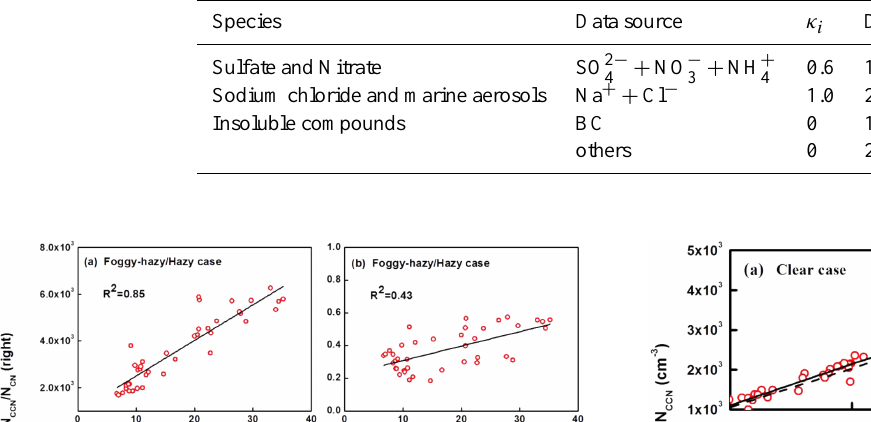
Table 3. Effective hygroscopicity parameters ( κ i ), and densities of the three category compositions in fine particles (Yue et al., 2011).